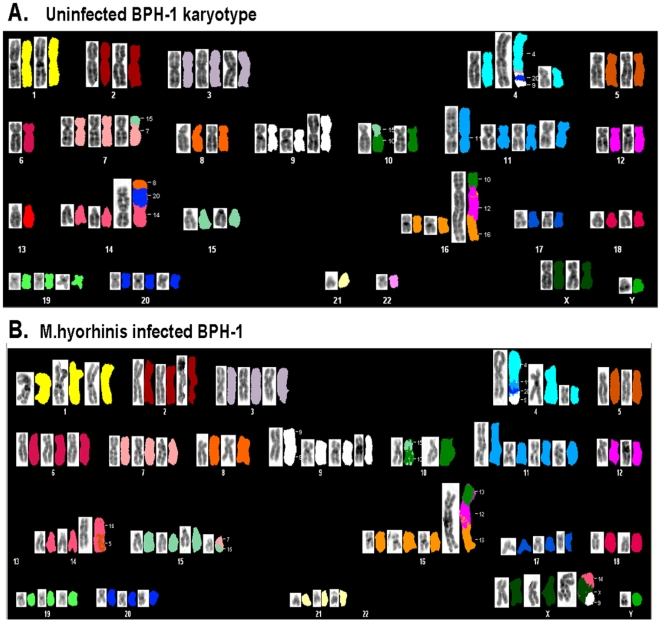
Cytogenetic analysis of mycoplasma infected BPH-1 cells.Metaphase chromosomal complement was revealed by spectral karyotyping (SKY) and counter-staining with DAPI. Representative metaphase cells after SKY classification are shown. A, uninfected BPH-1 cells. B, BPH-1 cells after 19 weeks M. hyorhinis infection. Composite for each chromosome shows, left to right, inverted DAPI-stained image, and spectral imaging color representation. Chromosome number is shown below image groupings, numbers alongside the derivative chromosomes indicate the origin of the translocated material. M. hyorhinis exposed BPH-1 cells were noted to harbor trisomy of chromosomes 1, 2, 6, 7, 15–18, and 21, in addition to loss of chromosome 13.